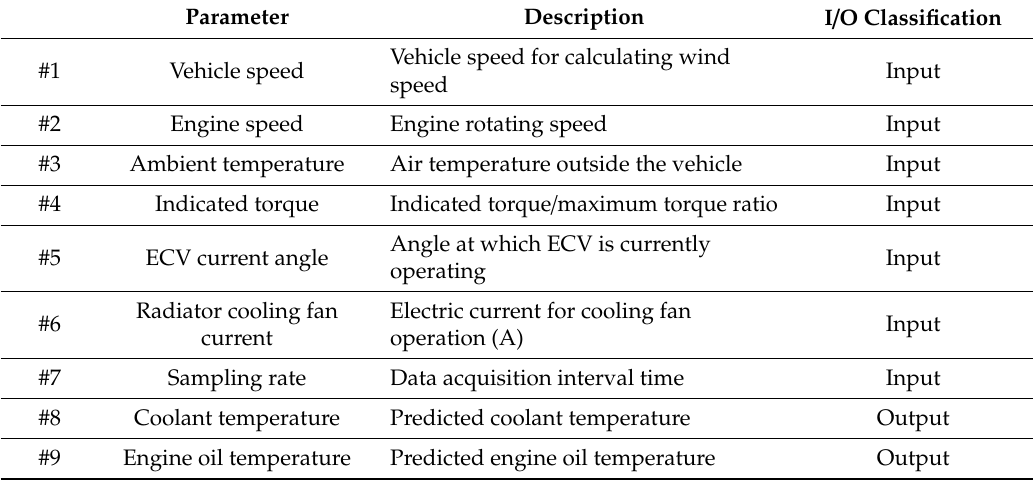
Table 3. Main input and output elements for physics-based and neural network (NN) models. Parameter